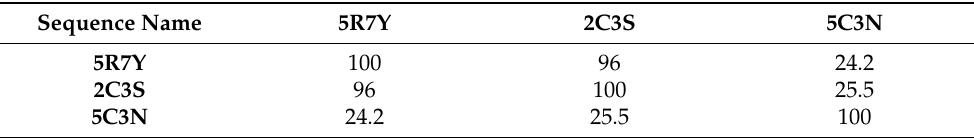
Table 1. Sequence comparison matrix of SARS-CoV-2 (PDB ID: 5R7Y), SARS-CoV (PDB ID: 2C3S), and MERS-CoV (PDB ID: 5C3N). Identity matrix is expressed as a